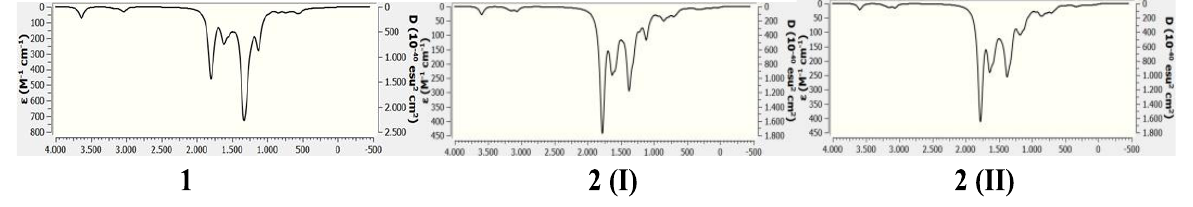
Figure 8. Calculated IR spectra of the studied compounds. Table 6. Vibrational frequencies (cm − 1 ) of some functional groups in the studied compounds. Table 7. Spectral data for the studied compounds, calculated at the B3LYP-D3/6-311++G(d,p) level and experimental one.